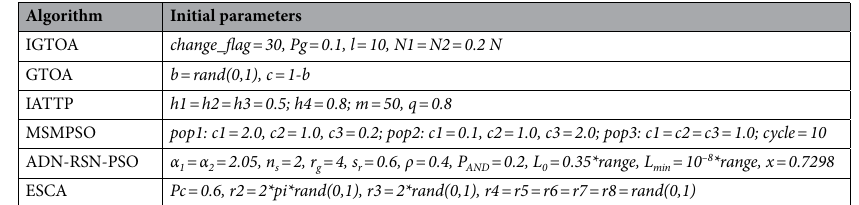
Algorithm Initial